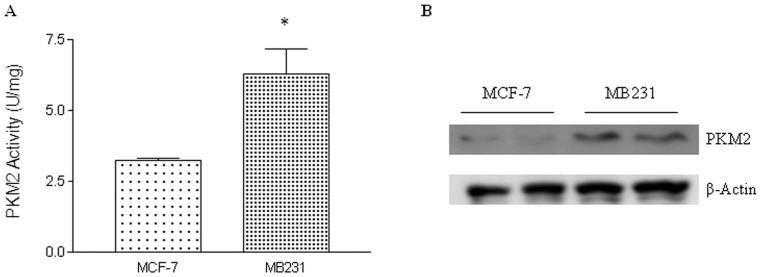
Enzymatic activity and expression levels of PKM2 were detected in both human breast cancer MDA-MB-231 (MB231) cells and MCF-7 cells.Whole cell lysate was subjected to activity and Western blot analysis to determine the enzymatic activity (A) and protein expression (B) of PKM2. β-Actin served as the loading control. * P<0.05 compared with MCF-7 cells.